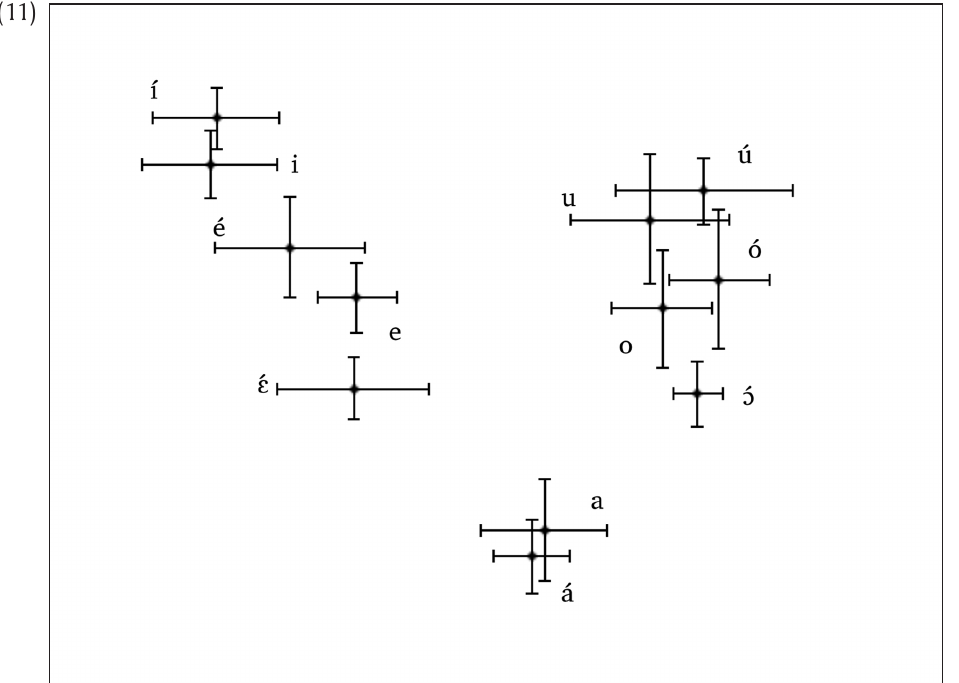
Figure 4: F1 (y axis) and F2 (x-axis) plot of tonic and pretonic vowels (normalized Hz) from set B; error bars indicate two standard